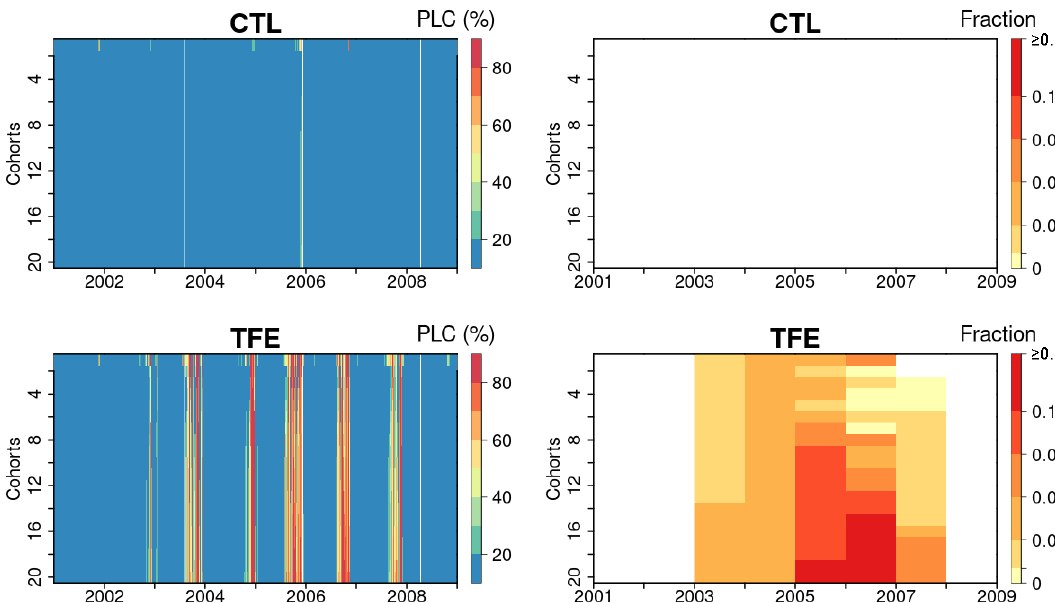
Figure 8. Percentage loss of daily stem conductance (PLC) (left) and tree mortality fraction simulated by ORCHIDEE-CAN-NHA (right). The vertical axis is for the index of 20 tree cohorts represented in the model, a larger index indicating taller trees (see Table S4 for tree height and diameter in each cohort). Tree mortality fraction per year is calculated by totaling the number of dead trees in each year and dividing it by the tree density on the first day of each year.